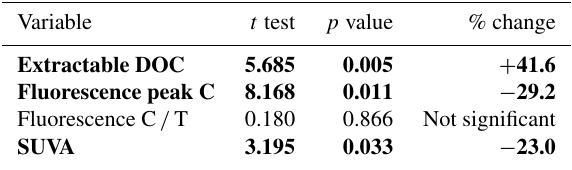
Table 2. Spearman’s ρ for different DOC quality and treatability measures.